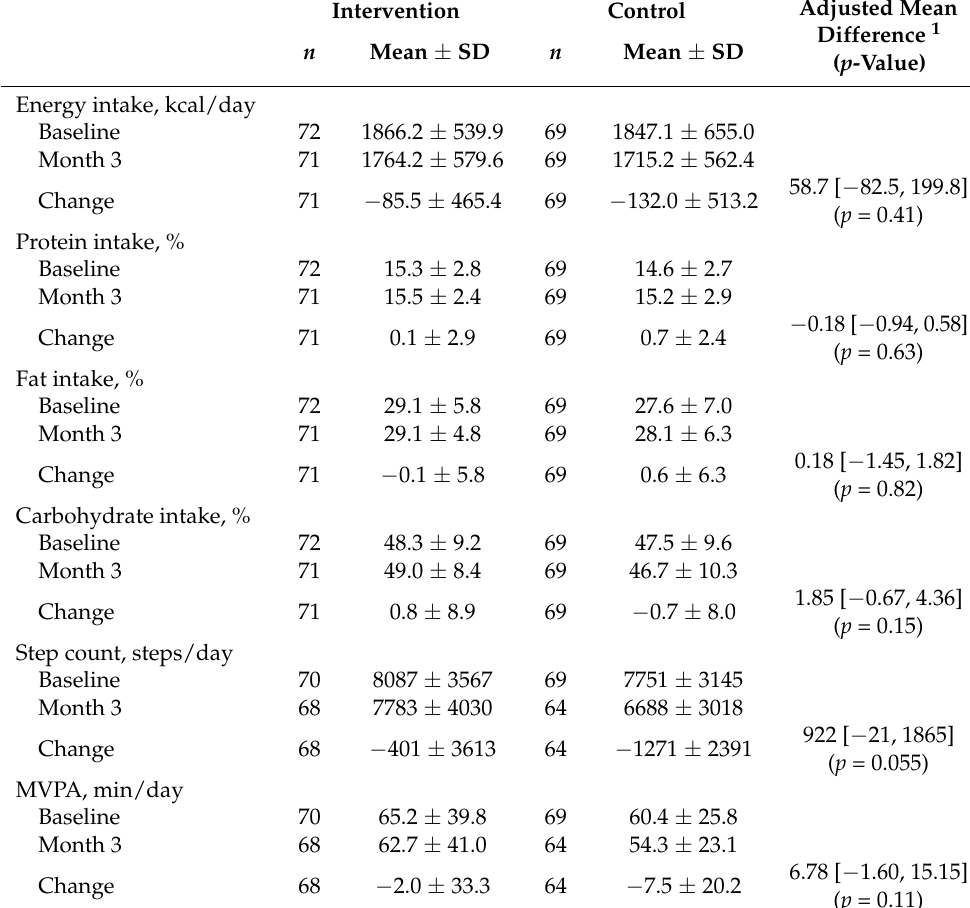
Table 3. Change in dietary intake by diet history questionnaire and physical activity over 3 months. Intervention Control Adjusted